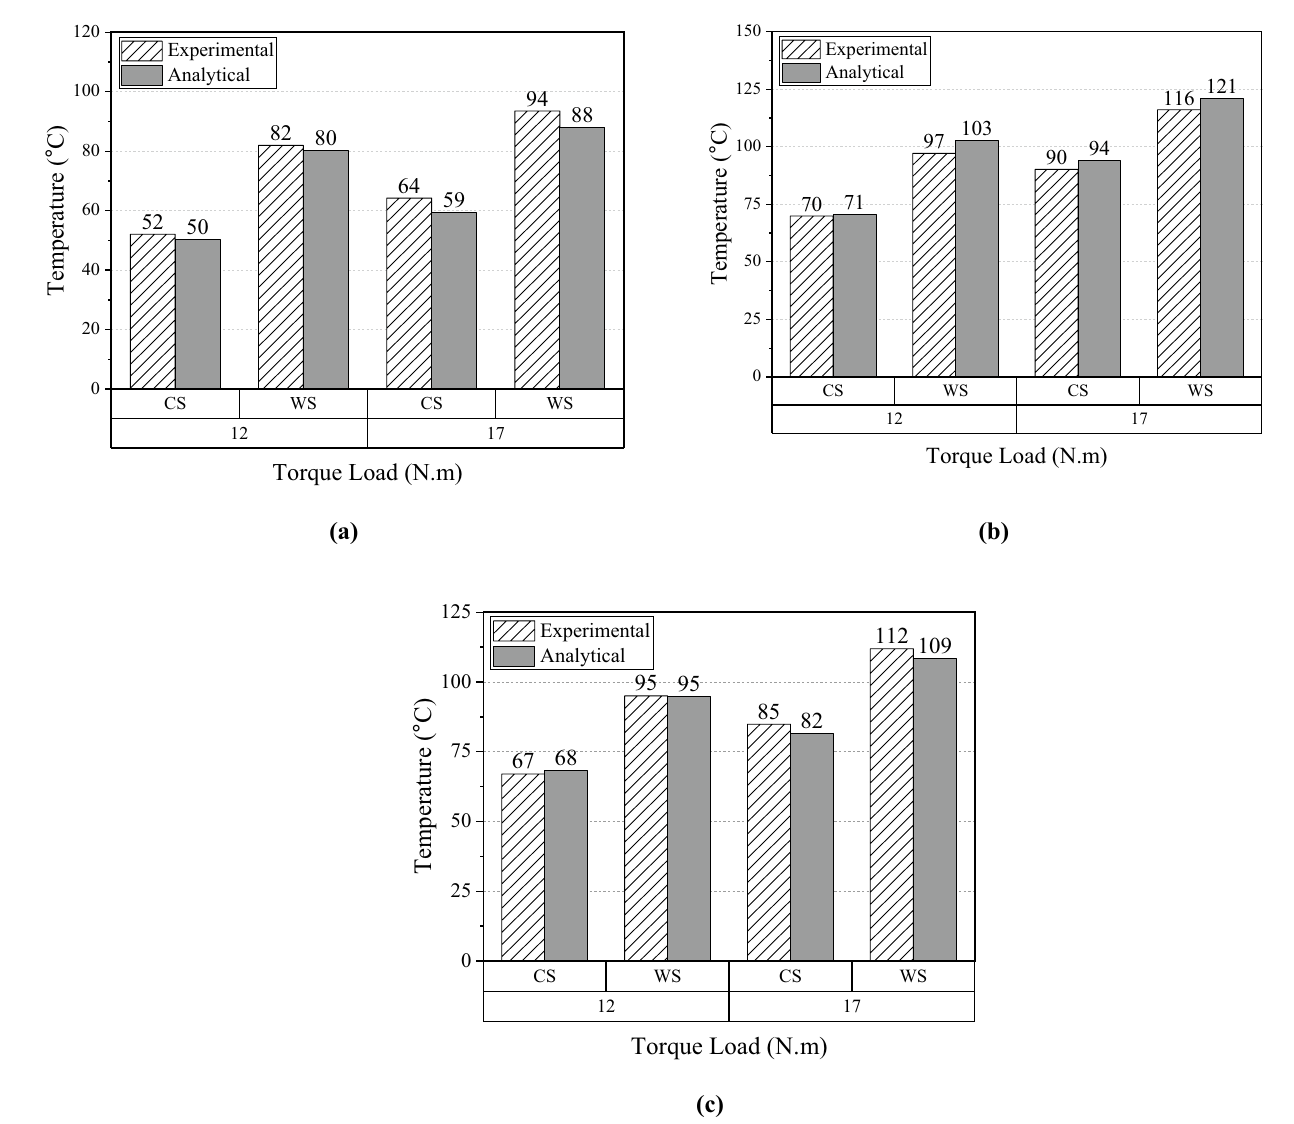
Figure 12. Temperature comparisons at different locations under 1200 RPM with various loads and CS and WS operating conditions. ( a ) DR pulley surface at outer radii. ( b ) DN pulley surface at outer radii. ( c ) Belt